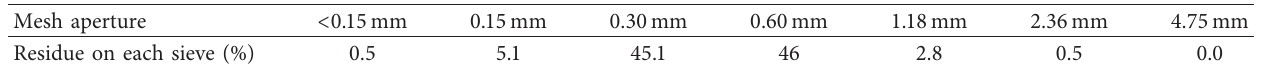
Table 4: Gradation of fine aggregate (residue on each sieve).